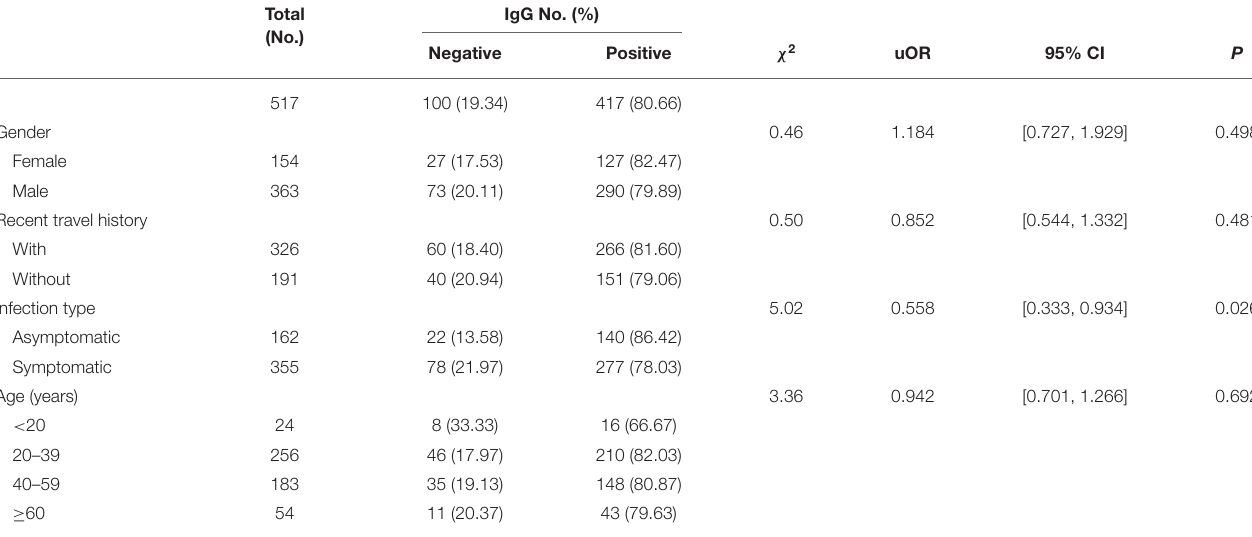
TABLE 2 | Demographic and clinical characteristics of IgG.